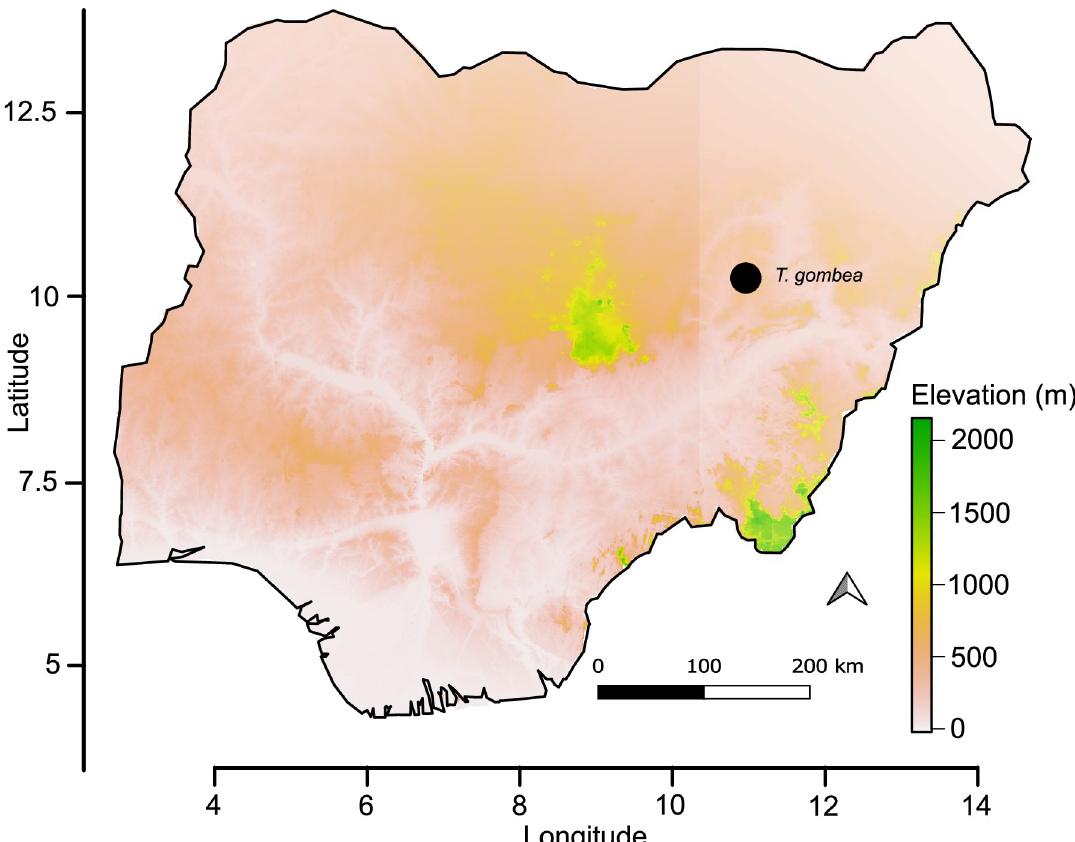
Fig 3. Distribution map of Tinnea gombea (black solid circle). The map was generated using naijR package version 0.4.0 as implemented in R version 4.2.0. and is therefore for illustrative purposes only.